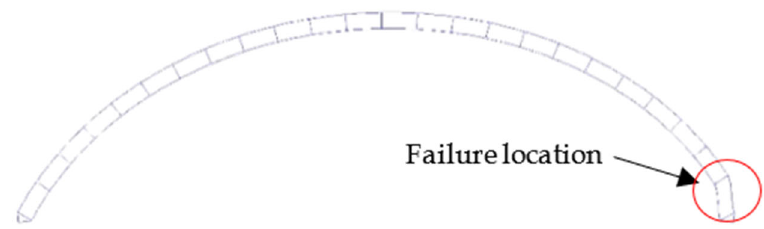
Figure 19. Global deformation and failure mode of chord local failure.